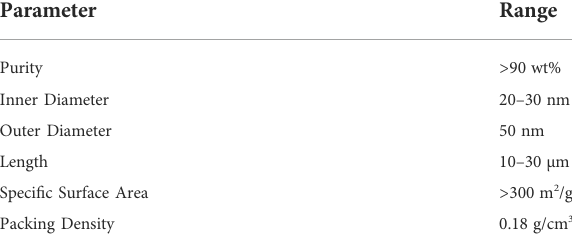
TABLE 1 Parameters of